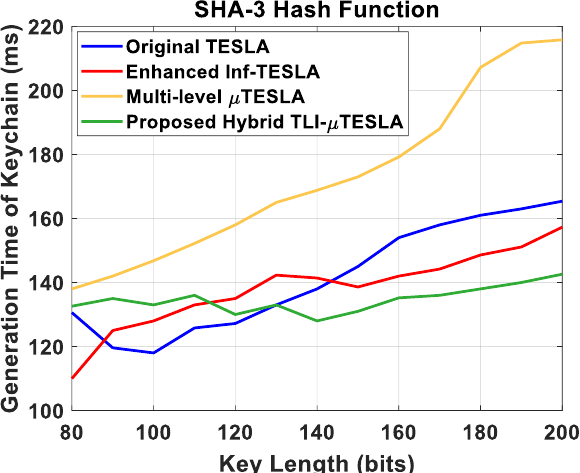
Figure 11. Simulation results of the original TESLA protocol (blue line), enhanced Inf-TESLA protocol (red line), Multilevel-µTESLA protocol (yellow line), and Proposed Hybrid TLI-µTESLA protocol (green line), demonstrating the computational overhead at the sender side during the generation of a keychain with the change in the key size using SHA-3 hash function.